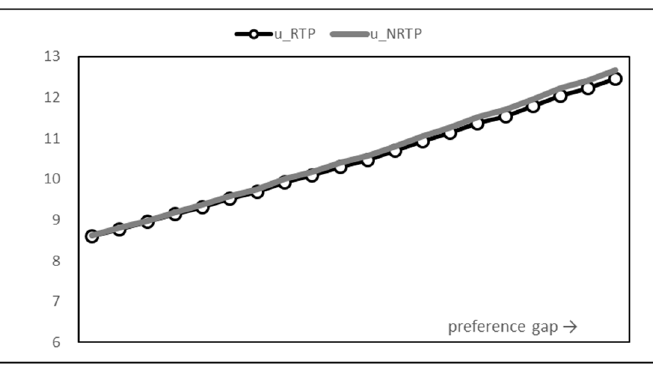
Figure 7. Utility graph.